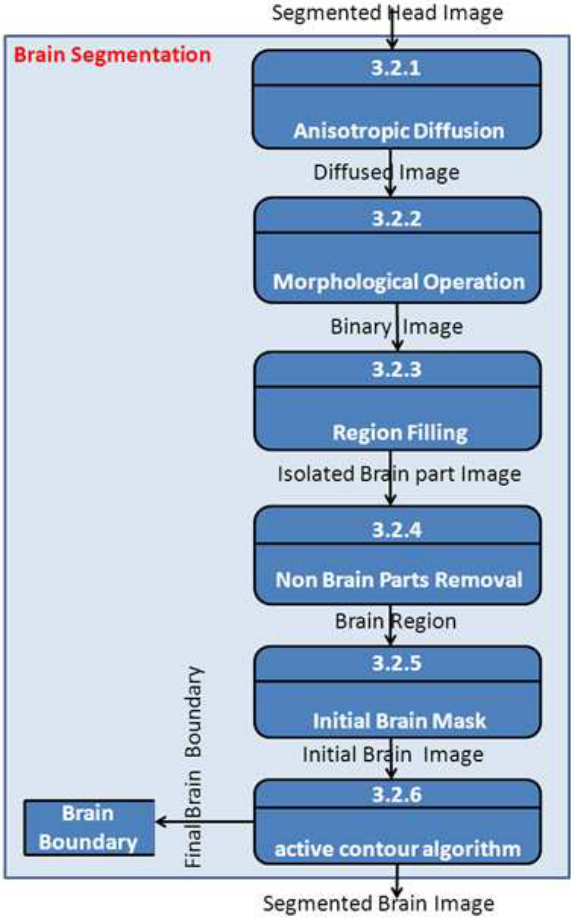
Fig.5 Architecture of the Brain Segmentation